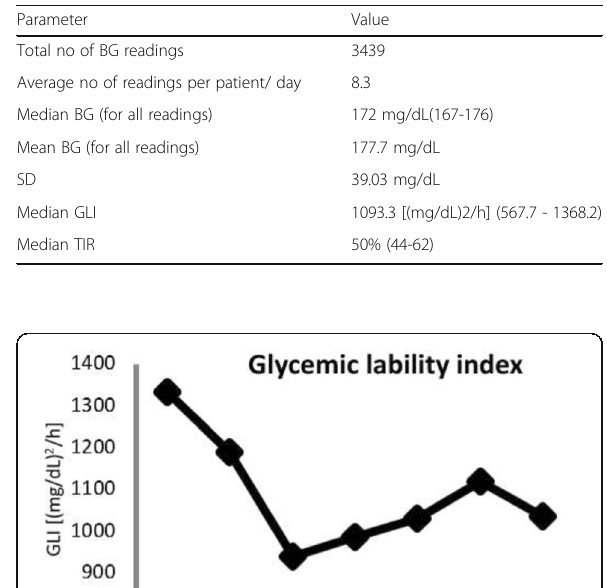
Table 1 (abstract 0107). Blood glucose(BG) values and glycemic metrics